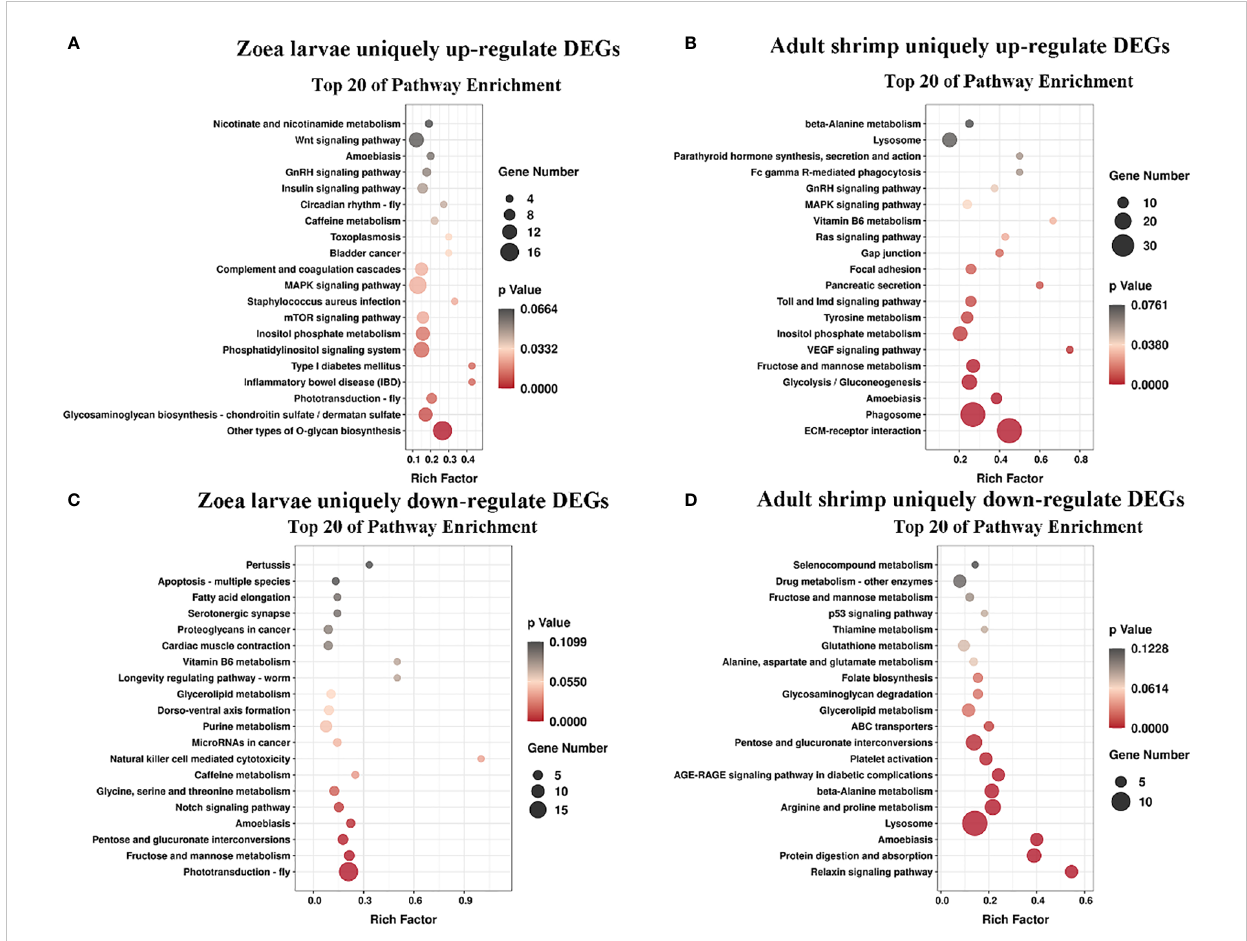
FIGURE 4 KEGG pathway enriched scatterplot. Axis represents the name of the pathway, the horizontal axis represents the corresponding rich factor of the pathway, the size of the p value is represented by the color of the point. The number of differential genes is indicated by the size of the point. (A) Enrichment of KEGG terms with unique up-regulated genes after Vibrio parahaemolyticus infection of Zoea larvae. (B) KEGG terminology enrichment of unique up-regulated genes after Vibrio parahaemolyticus infection of adults. (C) Enrichment of KEGG terms with unique down- regulated genes after Vibrio parahaemolyticus infection of Zoea larvae. (D) Enrichment of KEGG terms unique to down-regulated genes after Vibrio parahaemolyticus infection of